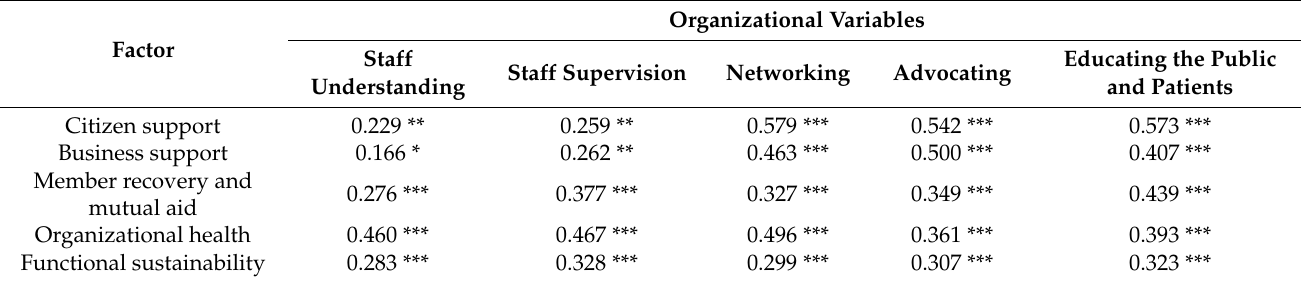
Table 5. Correlations between the five factors and the organizational